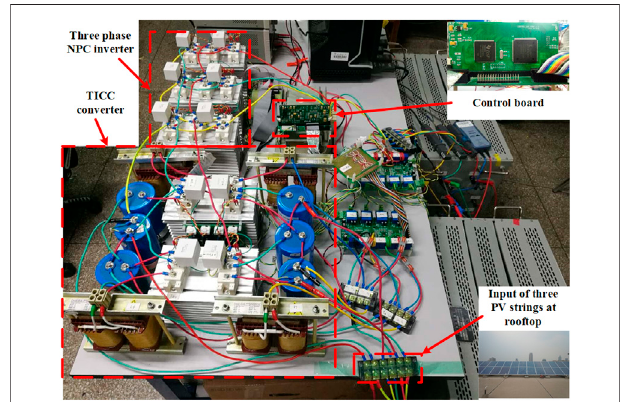
FIGURE 18 | Experimental testbed.